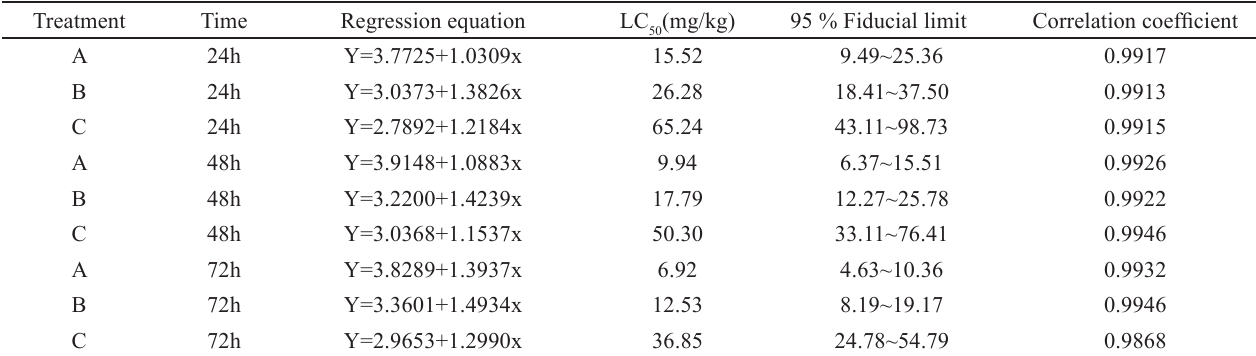
Table 3 . LC50 (mg/kg) of D. trifoliata roots extract, T. vogelii leaves extract, and rotenone against micrergates of